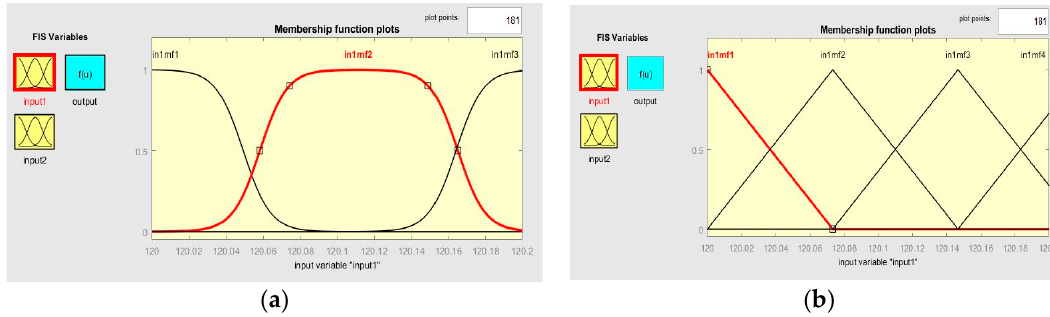
Figure 21. Fuzzy rules. ( a ) P-F ANFIS; ( b ) Q-V ANFIS.